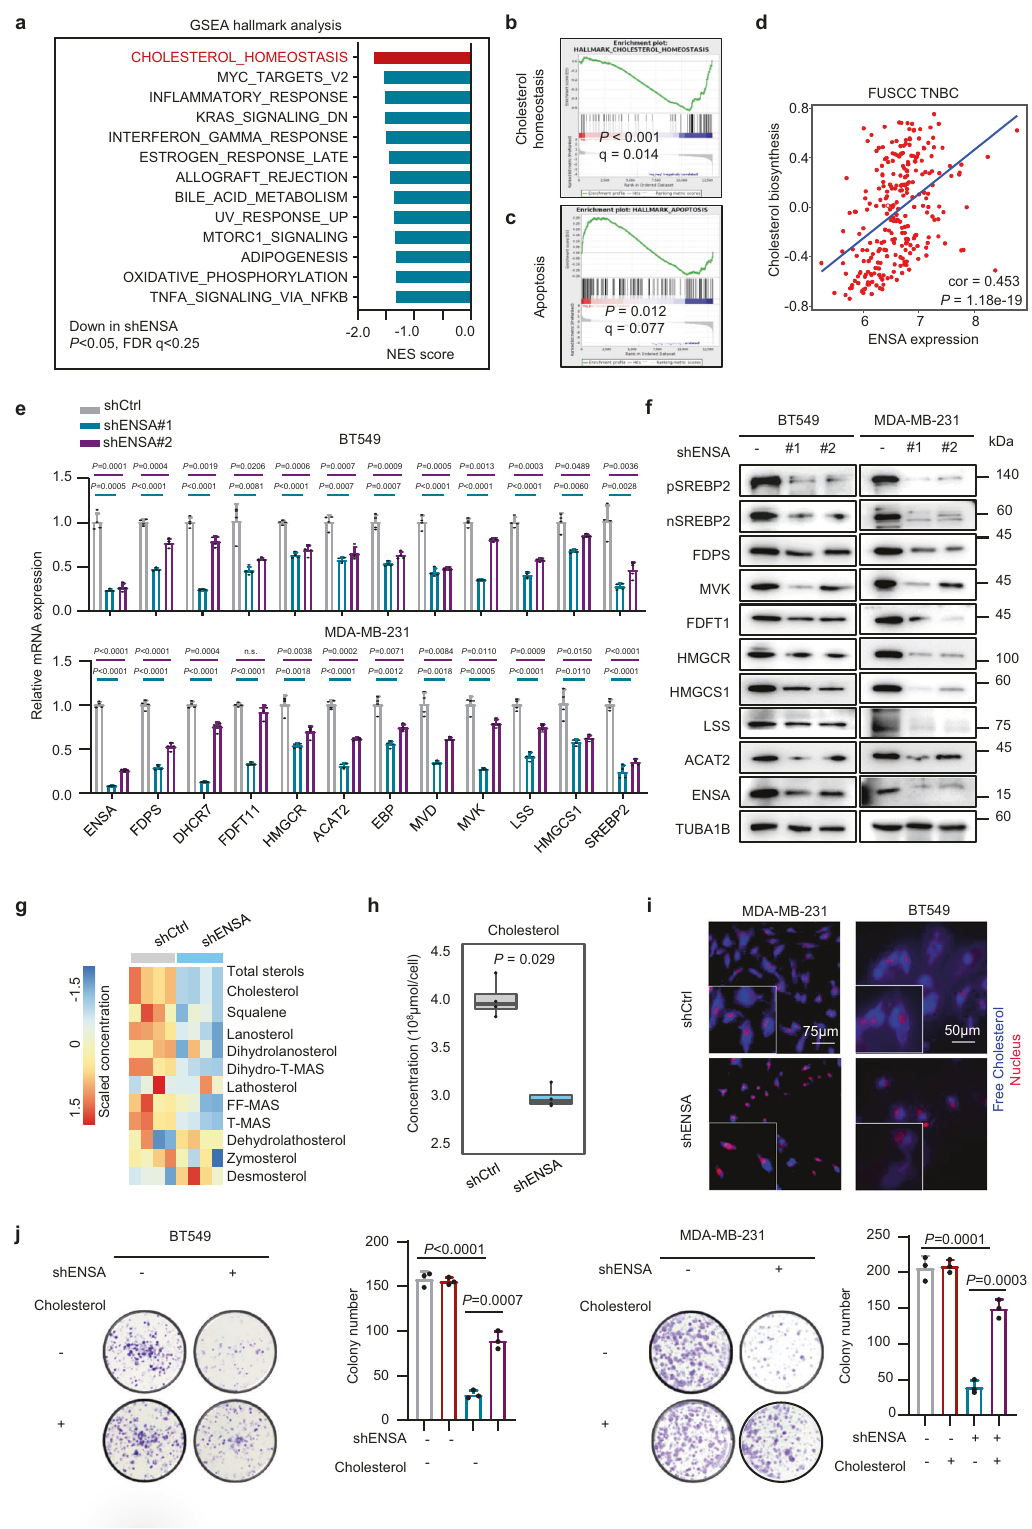
response in patients with TNBC, we constructed seven mini- ENSA expression level (Fig. 6c – e and Supplementary Fig. 7c). The patient-derived xenograft (mini-PDX) models, as reported clinicopathological features of these three organoids are shown in previously 24,25 , and measured the response for Stattic normalized Supplementary Table 1. We next explored the sensitivity of to vehicle treatment (Fig. 6h). The clinicopathological features of TNBC cells to Stattic in xenograft models and found signi fi cantly these TNBC models are shown in Supplementary Table 2. In line impaired sensitivity to Stattic when ENSA was depleted (Fig. 6f, g, with the results obtained above, ENSA-high tumors (578, 573, and Supplementary Fig. 7d, e). To further explore the drug NATURE COMMUNICATIONS| (2022) 13:791